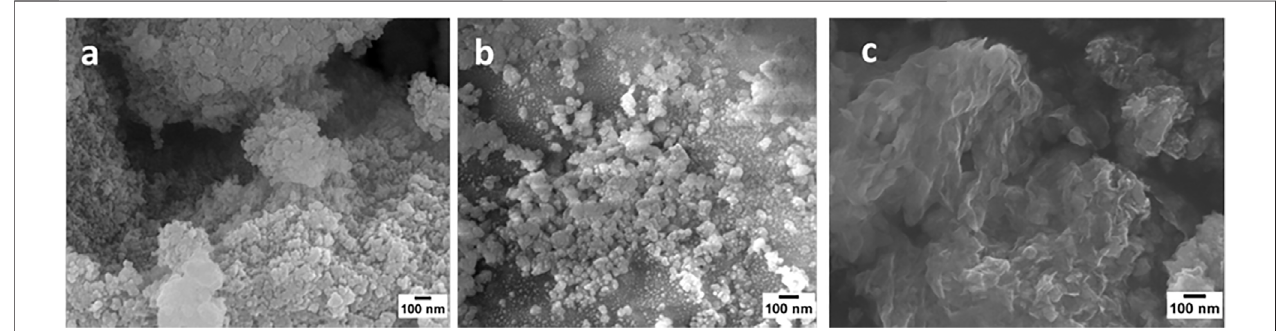
FIGURE 2 | SEM images of NiO (A) , NiO/ZnO (B) , and NiO/CuO (C) materials.